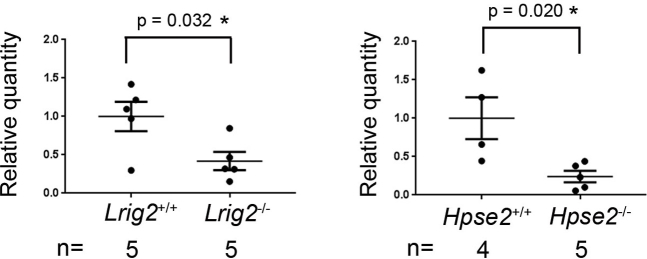
Quantitative reverse transcription–polymerase chain reaction for nitric oxide synthase 1 (Nos1) in neonatal bladders and attached outflow tracts. For both leucine-rich repeats and Ig-like domains 2 (Lrig2) homozygous mutant tissues and the heparanase 2 (Hpse2) mutant tissues, Nos1 transcripts levels were reduced compared with littermate control subjects. Values are shown as mean ± SEM, with the value for the mean of each wild-type group defined as “1.”